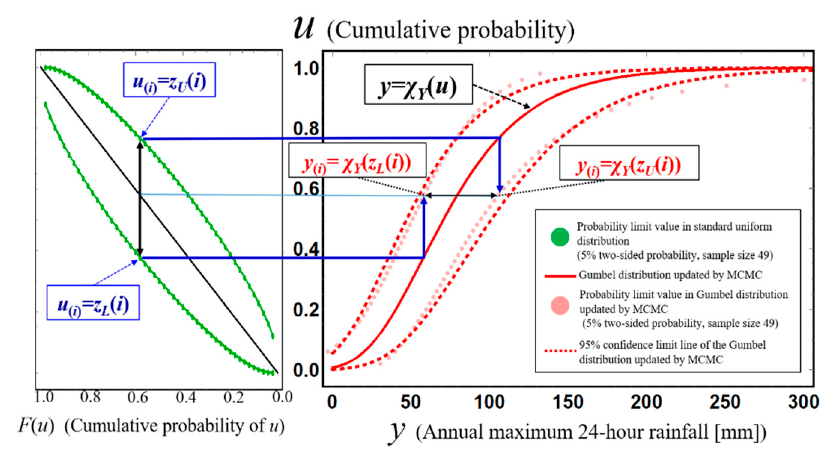
Figure 11. Construction process of 95% confidence interval for Bayesian-updated probability distribution based on probability limit method test for future climate. Y is the probability variable expressing Annual maximum 24-h rainfall in future climate.